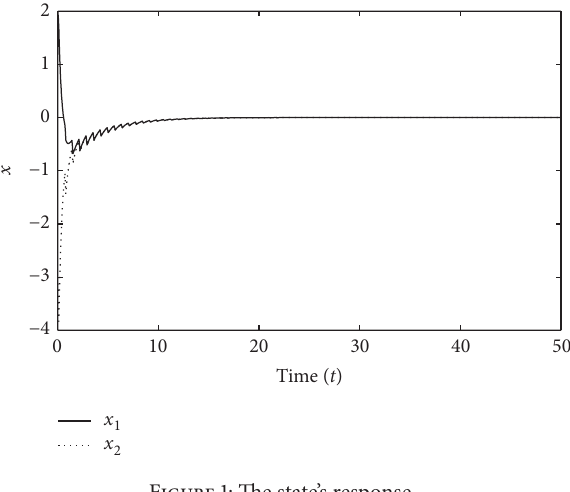
Figure 1: The state’s